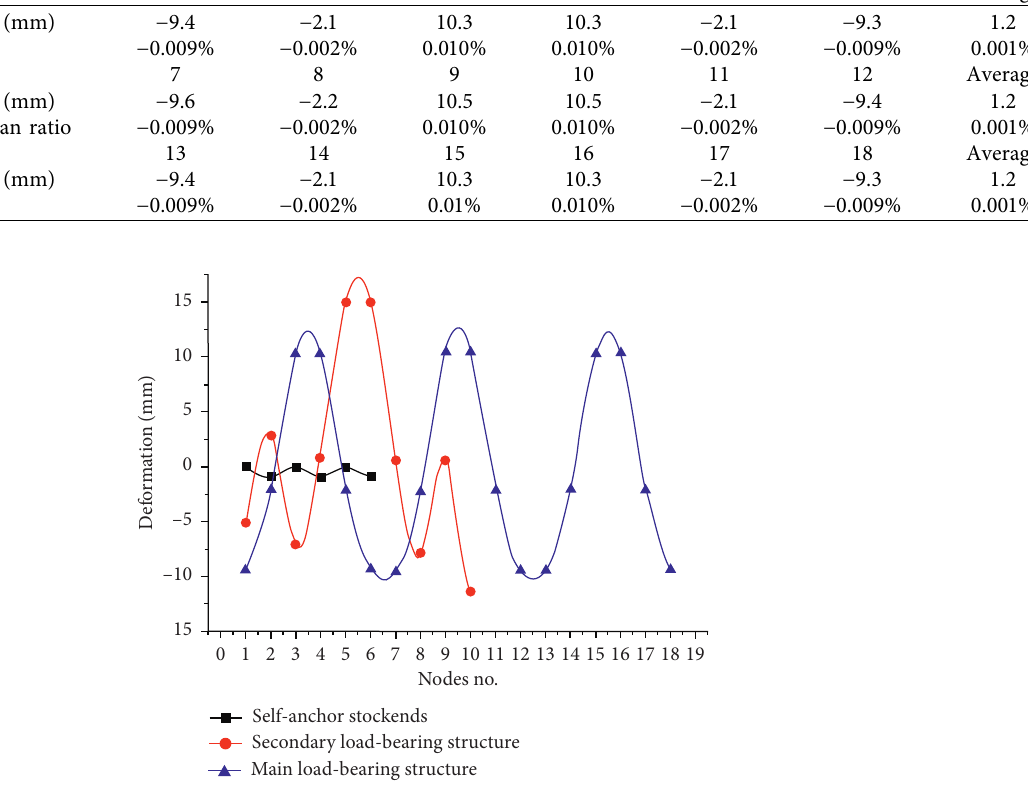
Figure 8: The deformation distributions of all concerned nodes. Table 3: Vertical deformation of main truss self-anchor stocks end nodes.